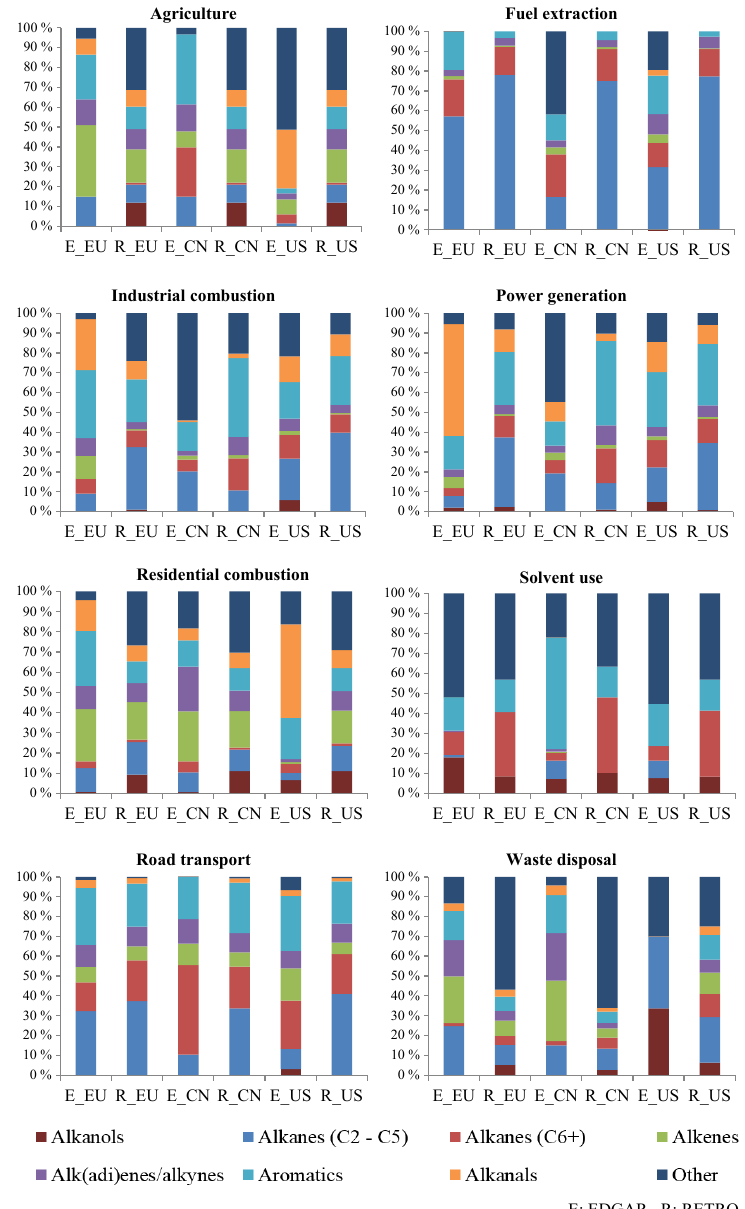
Figure 14. Comparison of NMVOC species composition of eight sectors between EDGAR (E) and RETRO (R) data sets for Europe (EU), China (CN), and the United States (US) in